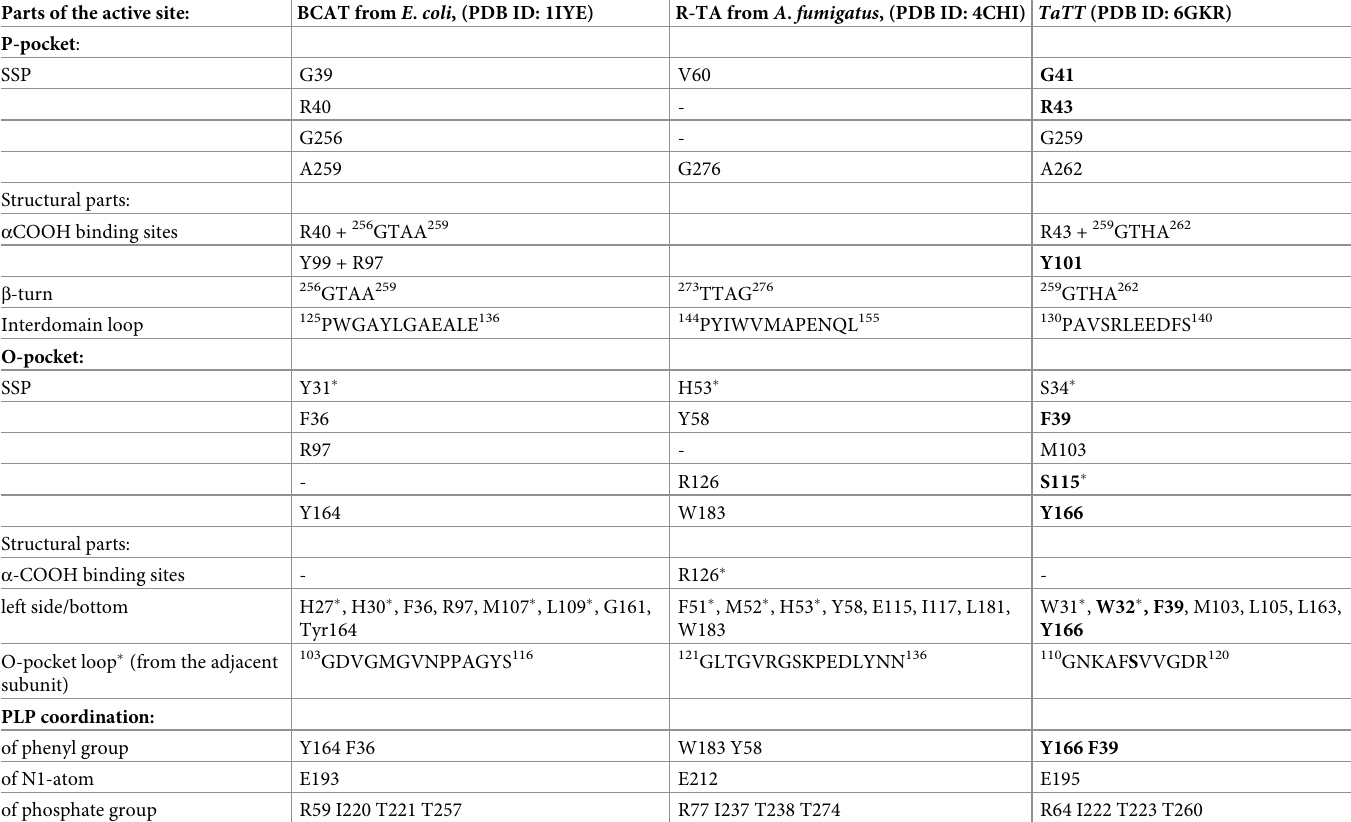
Table 2. The amino acid content of SSPs and structural parts of the active site of TaTT , BCAT from E . coli and R-TA from Aspergillus fumigatus . Parts of the active site: